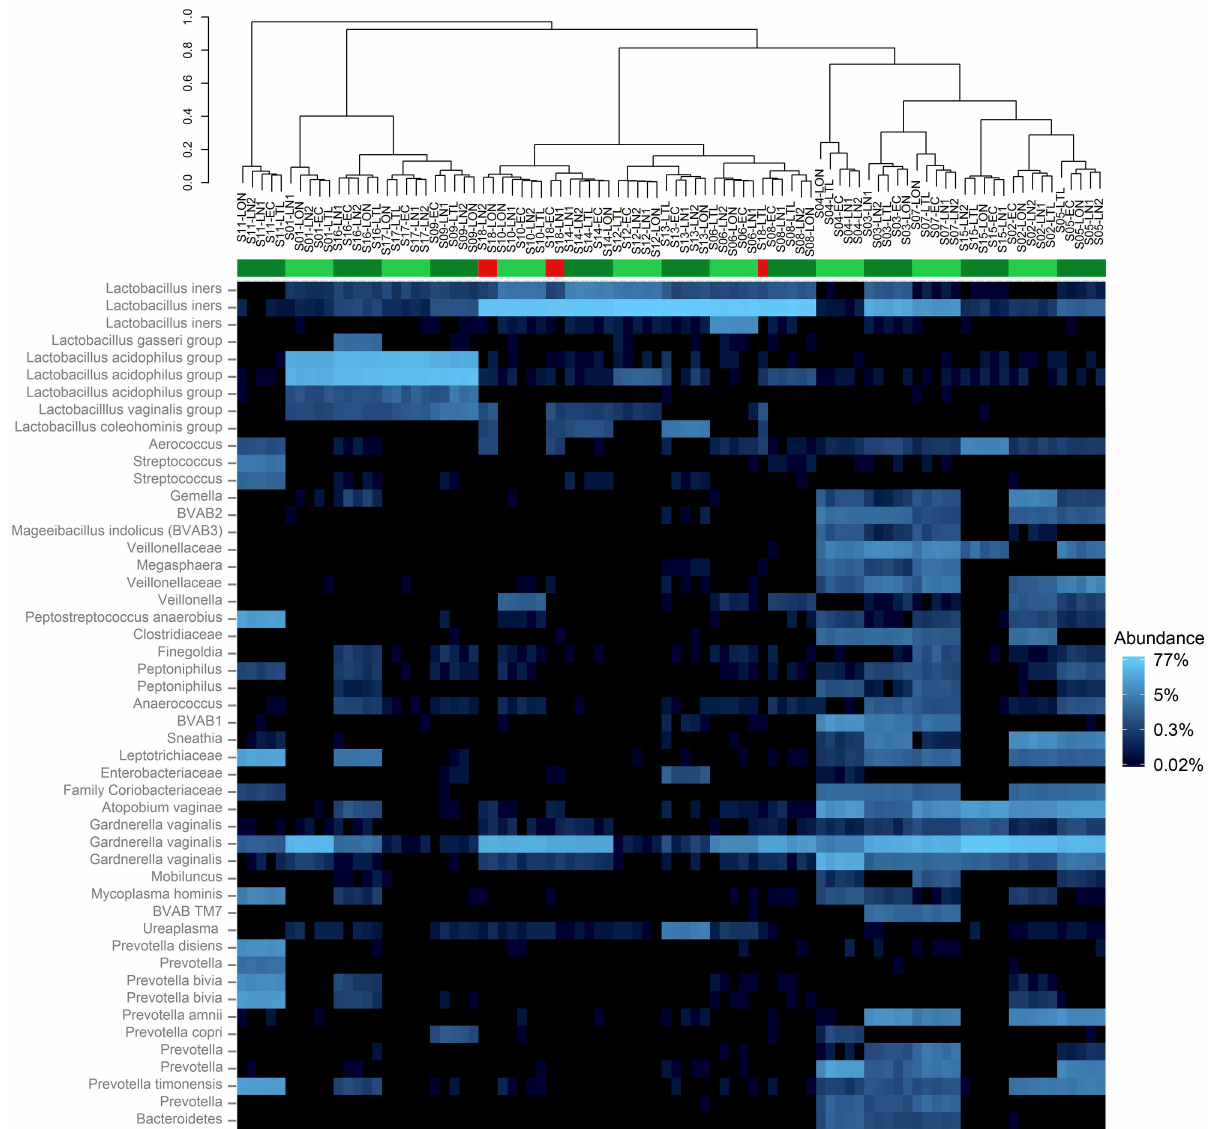
Fig 3. Heat map showingmost abundant operationaltaxonomicunits(OTUs) withsample extractsarranged by hierarchical clustering. All OTUs that were presentat 1% or higherin at least one sampleare shown. Extracts are named according to the sampleof originfollowed by the pretreatment lysis method used and are arrangedby Unweighted Pair GroupMethodwith ArithmeticMean (UPGMA) clusteringon the Bray-Curtisdissimilaritymatrix.The colouredbar indicateswhich extracts have clusteredmost closely with all other extracts fromthe same sample(green)and those that have not (red).Reads have been assignedto OTUs based on 97% sequence similarityof the V3–V4 region.Note that in some cases this has resultedin multipleOTUs with the same taxonomicspecies identifier, which is most likely due to a high degree of intraspecies variabilityin this regionof the gene, or incorrectbase calling. Lactobacillus species that could not be identifiedto species level at the 97% cut-offhave been assignedto genus subgroups: L . gasseri group (including L . gasseri and L . johnsonii ), L . acidophilus group (including L . acidophilus , L . helveticus , L . gallinarum , L . crispatus , L . jensenii and L . delbruekii ), L . vaginalis group (including L . vaginalis and L . reuteri )and L . coleohominis group (including L . coleohominis and L . pontis